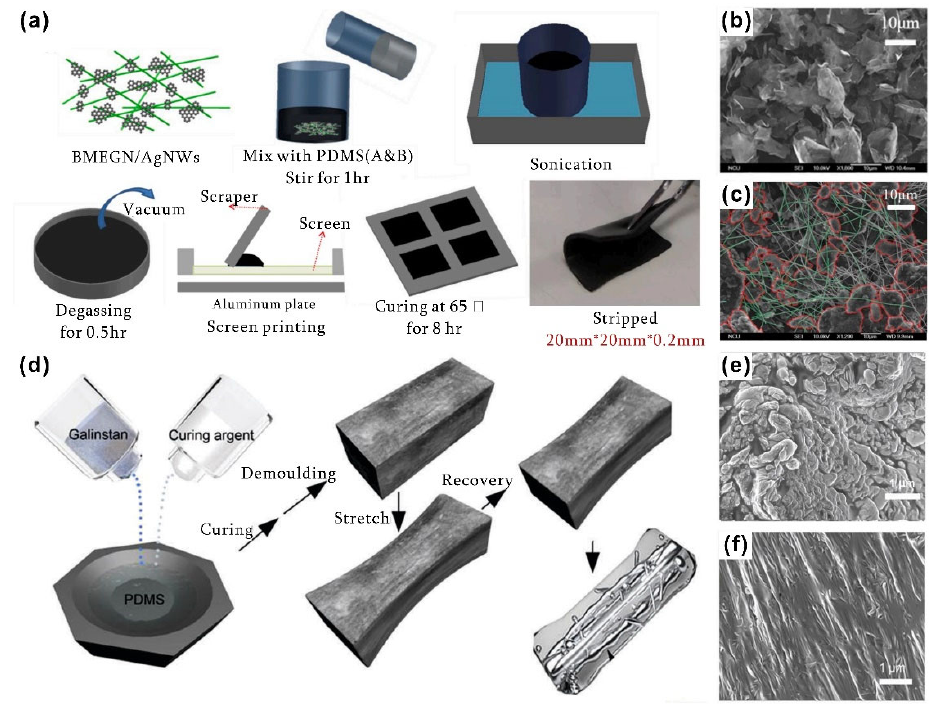
Figure 5. ( a ) The fabrication procedure for hybrid fillers incorporated into a PDMS matrix. ( b ) Pristine 2D graphite nanoplate filler. ( c ) The uniform dispersion of 2D graphite nanoplates with 1D silver nanowires with a 3D interconnected network in the PDMS matrix (Figure 5a–c reprinted/adapted with permission from Ref. [98]. 2020, Elsevier). ( d ) The mixing process for liquid metals with PDMS. ( e , f ) The micro/nanochannels of liquid metal inclusions formed with 10% and 50% deforma- tion quantity (Figure 5d–f reprinted/adapted with permission from Ref. [99]. 2018, Royal Society of